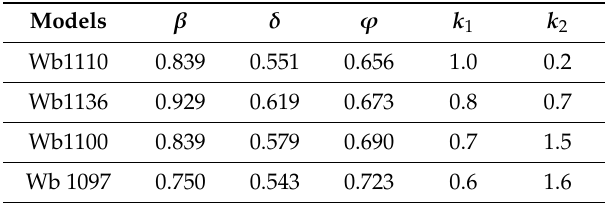
Table 6. Comparison of the hull ship parameters of the models with α =